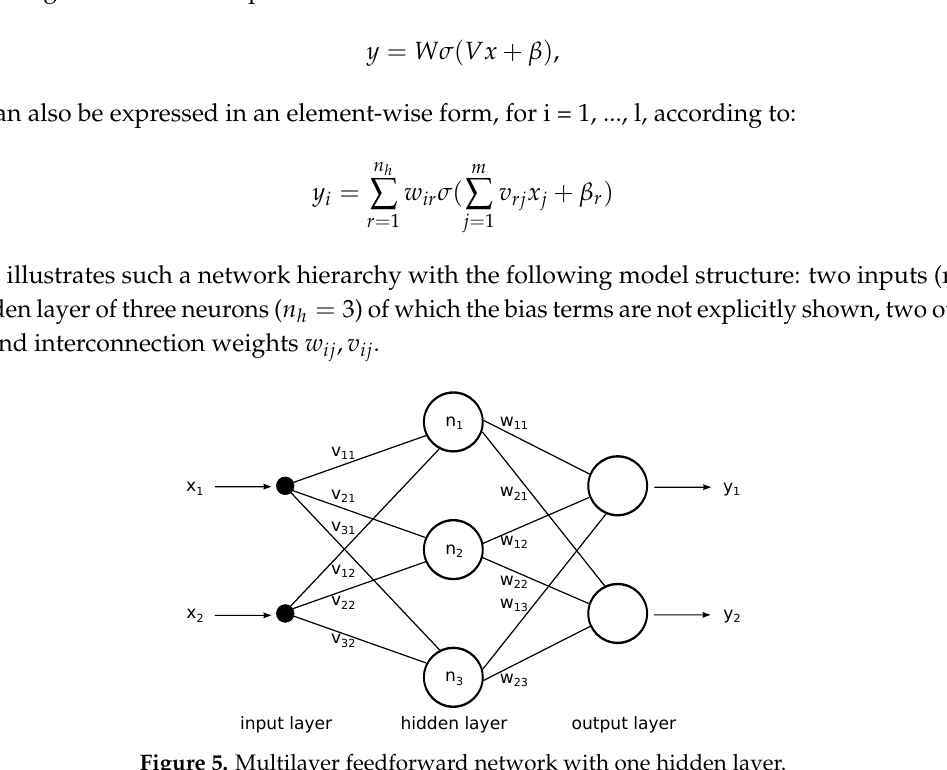
Figure 5. Multilayer feedforward network with one hidden